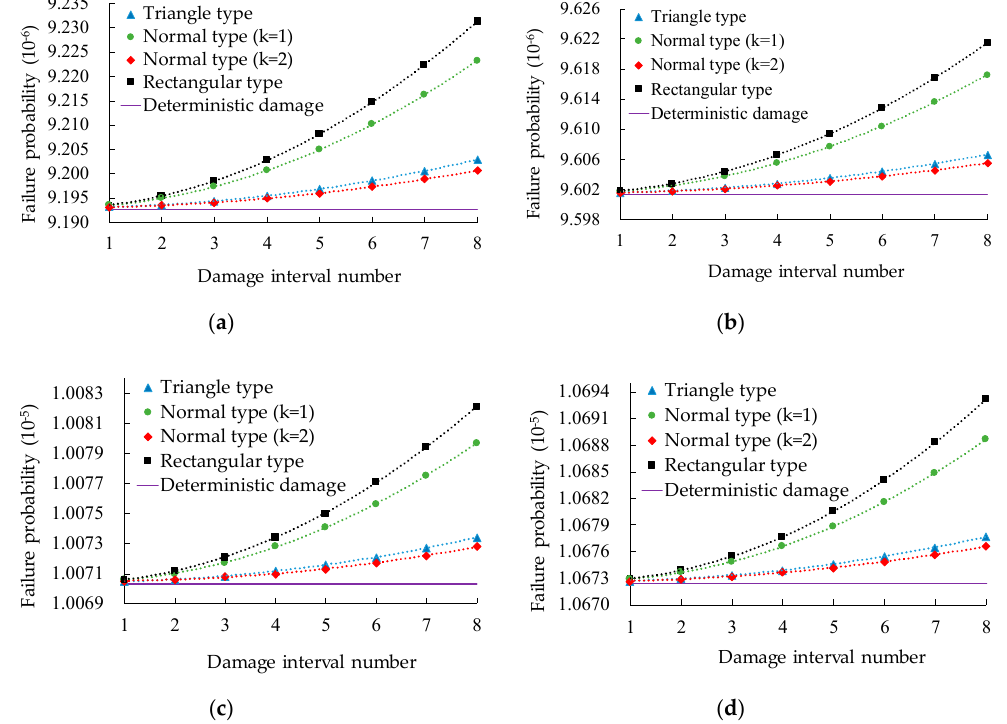
Figure 4. Failure probability of 1# slab in different hinge joint damage intervals under different membership functions. (The maximum credibility is 0.4): ( a ) Hinge joint damage case 1; ( b ) hinge joint damage case 2; ( c ) hinge joint damage case 3; ( d ) hinge joint damage case 4.